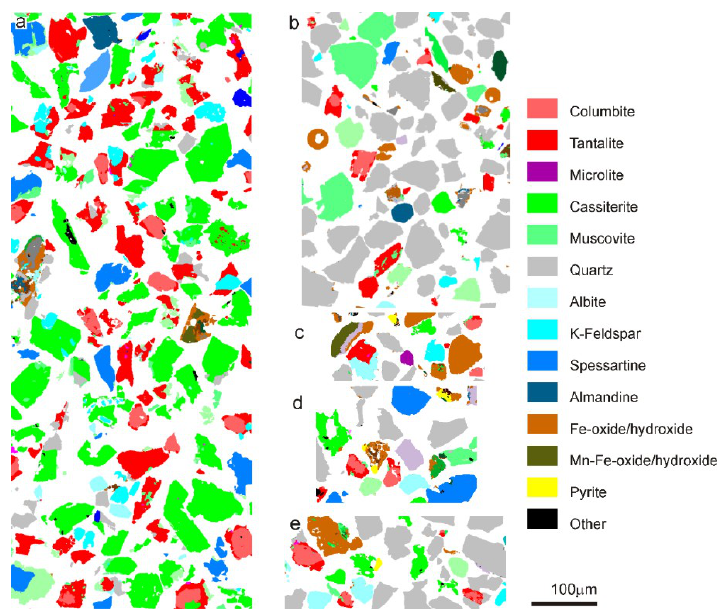
Figure 10. Representative pseudo-colour particle maps from the mineral liberation analysis of the ore